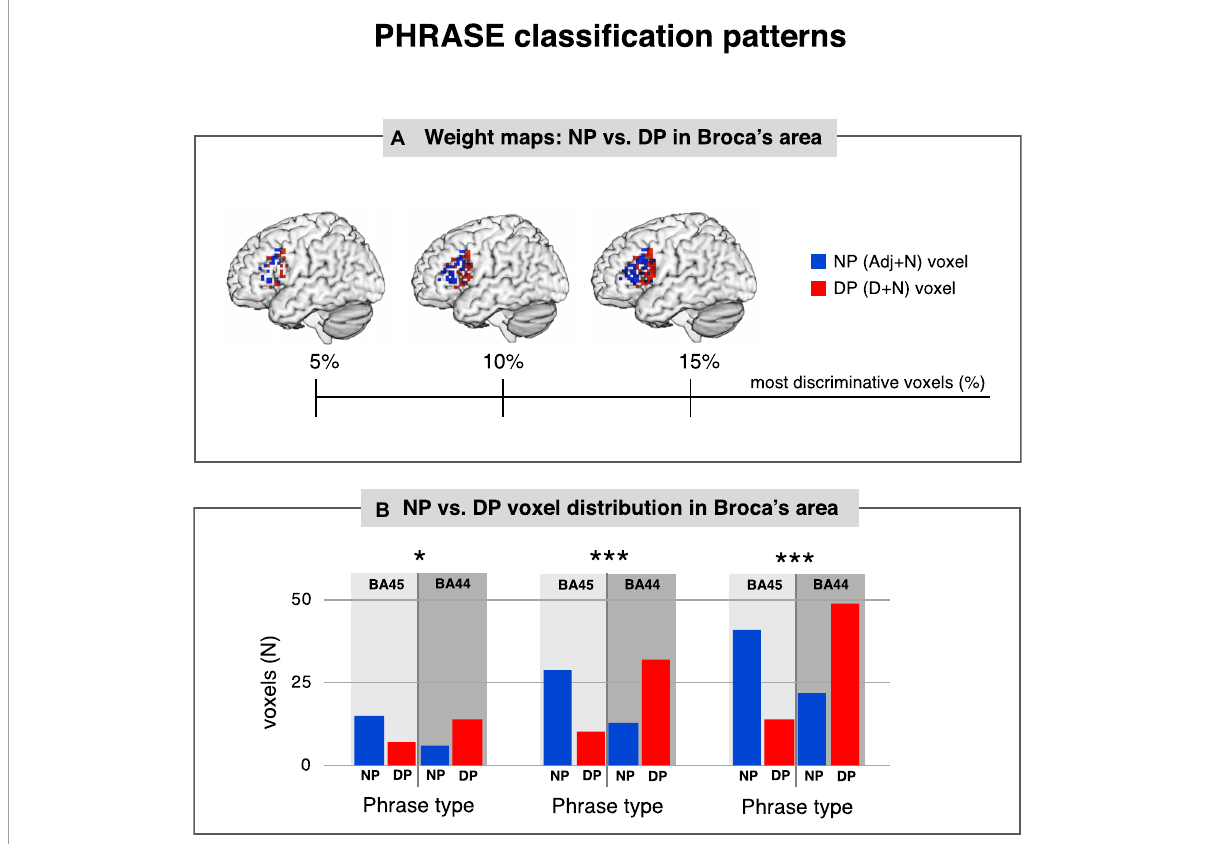
FIGURE3 PHRASE classification patterns. (A) Weight maps: NP vs. DP in Broca’s area. The most discriminative 5, 10, and 15% of classifier weights from the classifier trained to discriminate DP vs. NP, along the PHRASE factor in Broca’s area. (B) NP vs. DP voxel distribution in Broca’s area. PHRASE classification χ 2 -tests showed significantly distinct distributional patterns in Broca’s area for the 5% (left), 10% (middle) and 15% (right) most discriminative voxels, with voxels identifying determiner + noun combinations being strongly located in BA44, while voxels classifying adjective + noun combinations being conversely located in BA45. NP, noun phrase; DP, determiner phrase. * p < 0.05, *** p < 0.001. Figure created using the Multi-Image Analysis GUI viewer (Mango, Version 4.1; http://ric.uthscsa.edu/mango/) and MATLAB 7.14.0.739 (R2012a, Mathworks, Inc., Sherborn, MA,